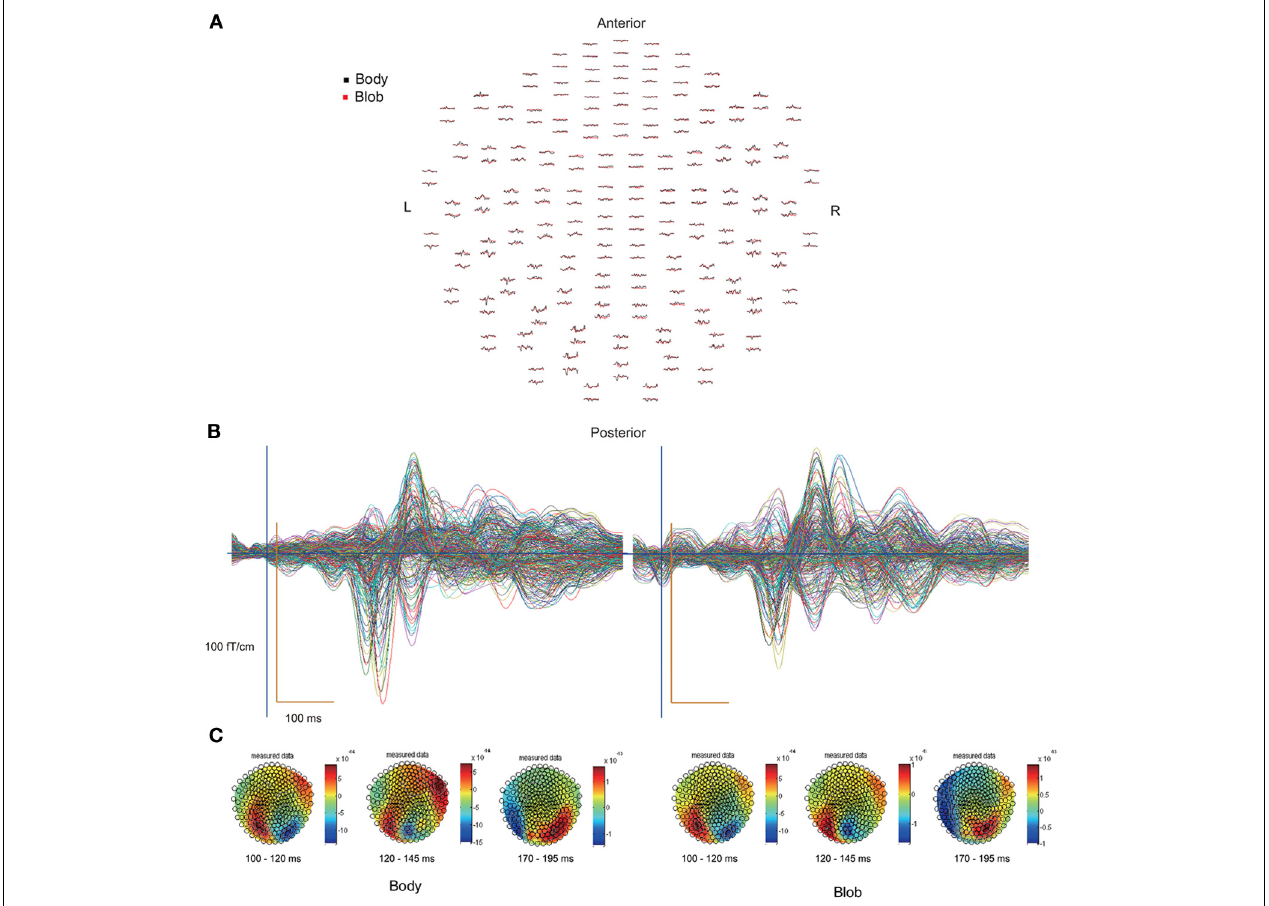
FIGURE 2 | (A) Whole-scalp sensors waveforms (body, black line; blob, red line) and (B) super-imposed waveforms of the “body” and “blob” responses in a representative subject. (C) MEG contour maps at 115, 135, and 187ms, respectively, after stimulus onsets.